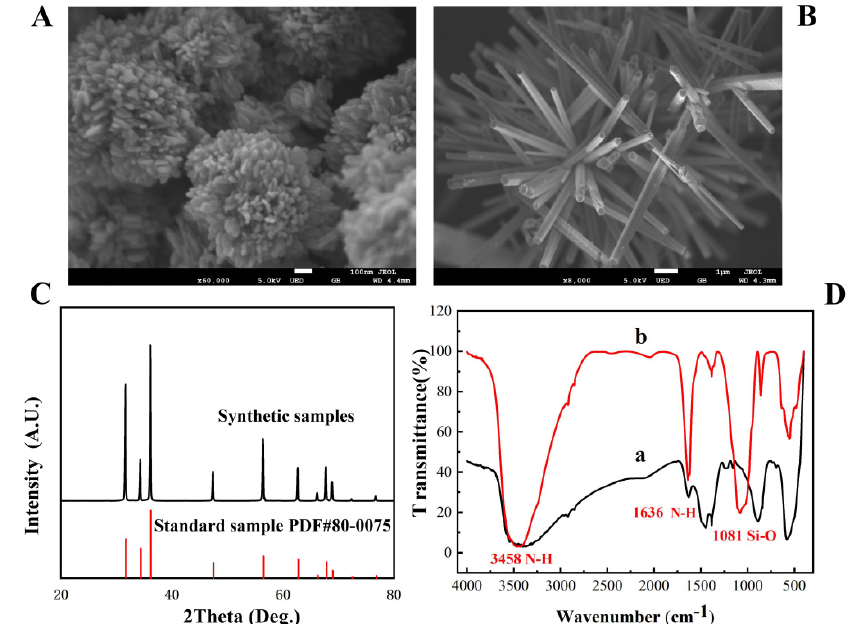
Figure 1. The SEM image of flower-shaped nano-ZnO ( A ) and brush-shaped nano-ZnO ( B ); XRD patterns of ZnO ( C ); FT-IR spectrum of amino-modified nano-ZnO ( D ).